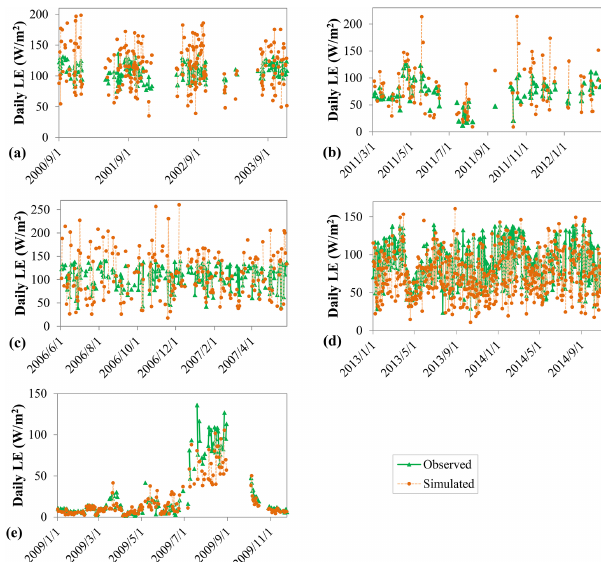
Figure 5. Observed and simulated daily LE series by the sine func- tion upscaling method in tropical regions. Note: (a) to (c) represent BR-Sa3, GH-Ank, and ID-Pag, located in the tropical rainforest cli- mate region; (d) and (e) are the sites of PH-RiF and SD-Dem, lo- cated in the tropical monsoon and grassland climate regions, respec- tively.